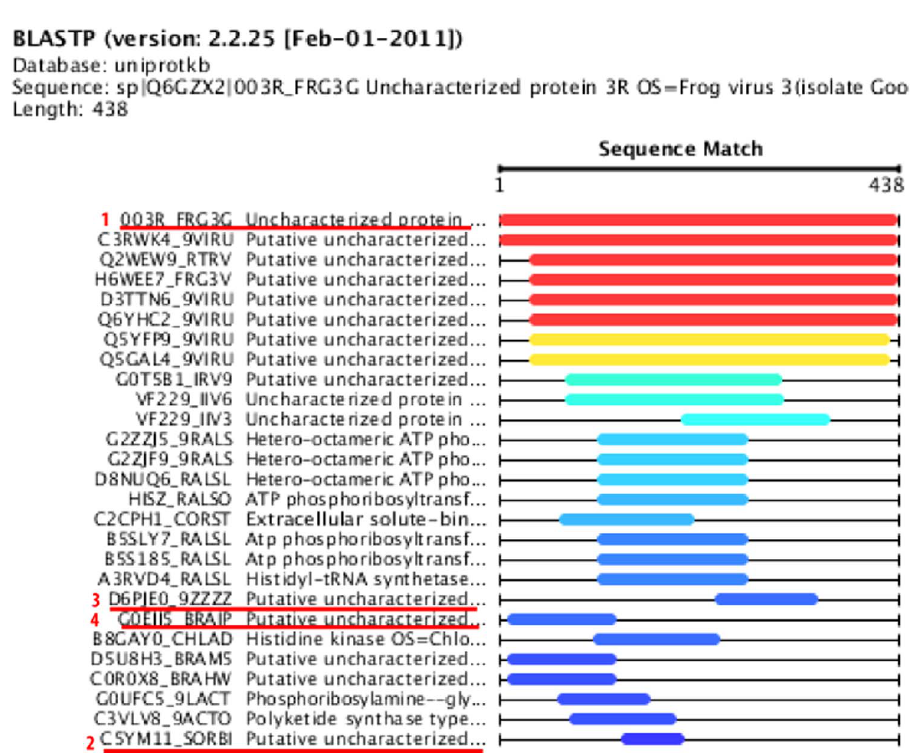
Fig. 1. A result set obtained from a BLAST sequence search. Underlined sequences are chosen as top-4 diverse results and the red numbers next to sequences represent the inclusion order into the diversified set.